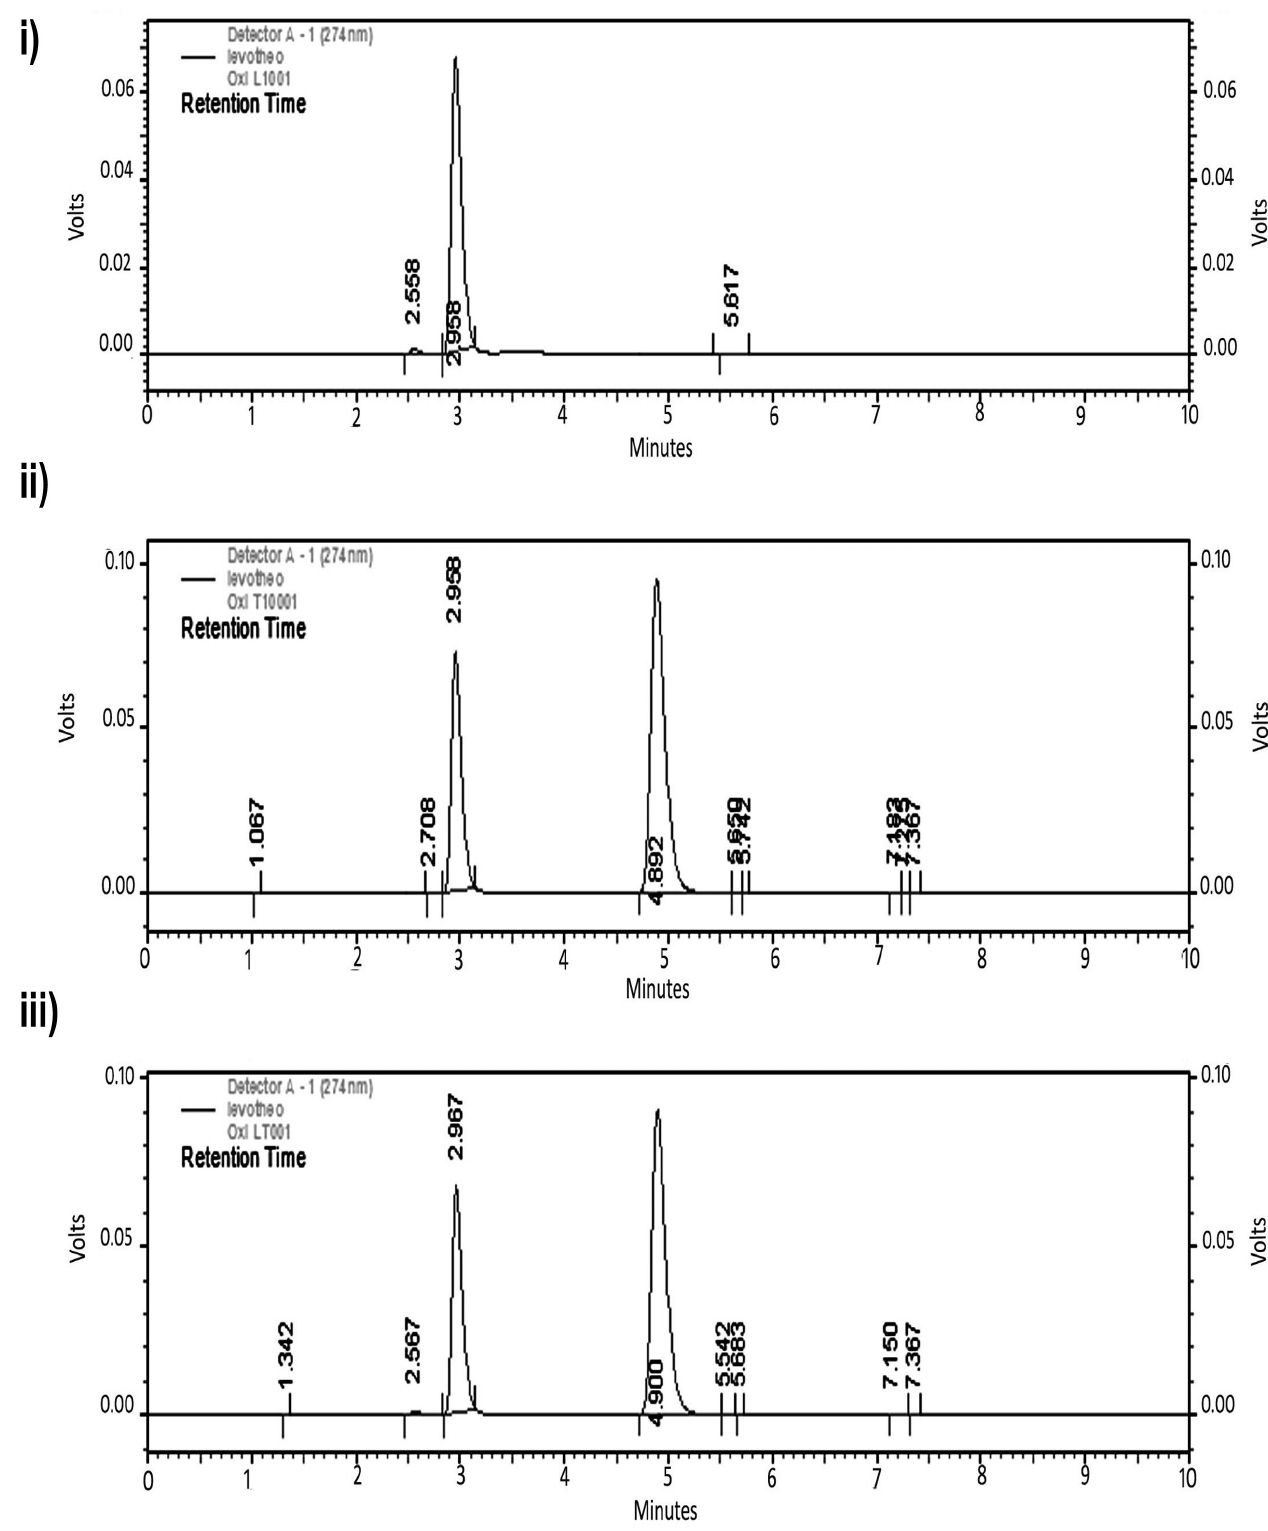
FIGURE 3D - Representative chromatograms of oxidation degraded drugs. Each chromatogram represents (i) levosalbutamol sulfate (1 μg. mL -1 ), (ii) theophylline (10 μg. mL -1 ), (iii) dosage form having levosalbutamol sulfate (1 μg. mL -1 ) and theophylline (10 μg. mL -1